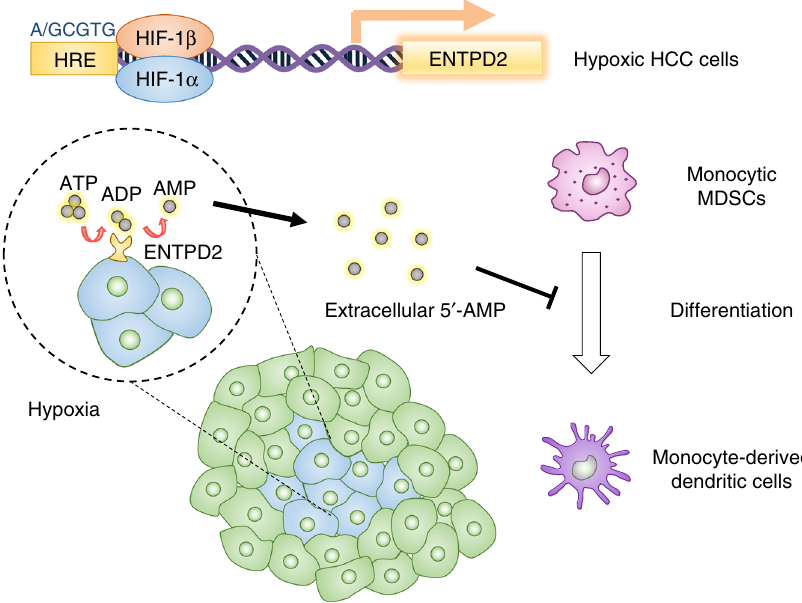
Fig. 7 Schematic representation of hypoxia-induced MDSC accumulation. Hypoxia stabilizes HIF-1 α in cancer cells. HIF-1 α binds to the HRE in the promoter of ENTPD2 to initiate transcription in cancer cells. ENTPD2 facilitates the dephosphorylation of extracellular ATP into 5 ′ -AMP. Increase in extracellular 5 ′ -AMP prevents M-MDSCs from maturation at tumor sites, thereby promoting tumor-mediated immune escape. Inhibition of ENTPD2 reduces the number of tumor-in fi ltrating MDSCs and increase the ef fi cacy of PD-1/CTLA-4 immune checkpoint